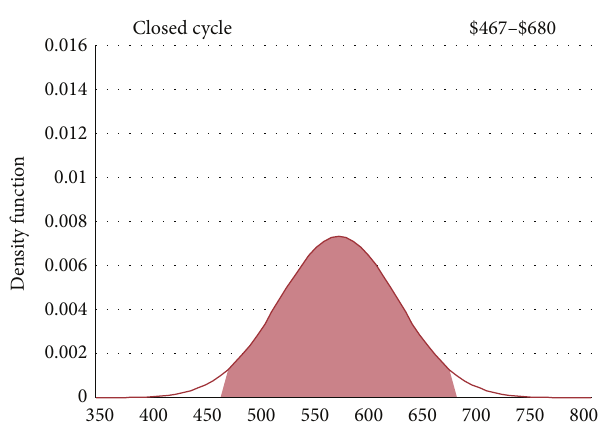
Figure 6: Range for closed